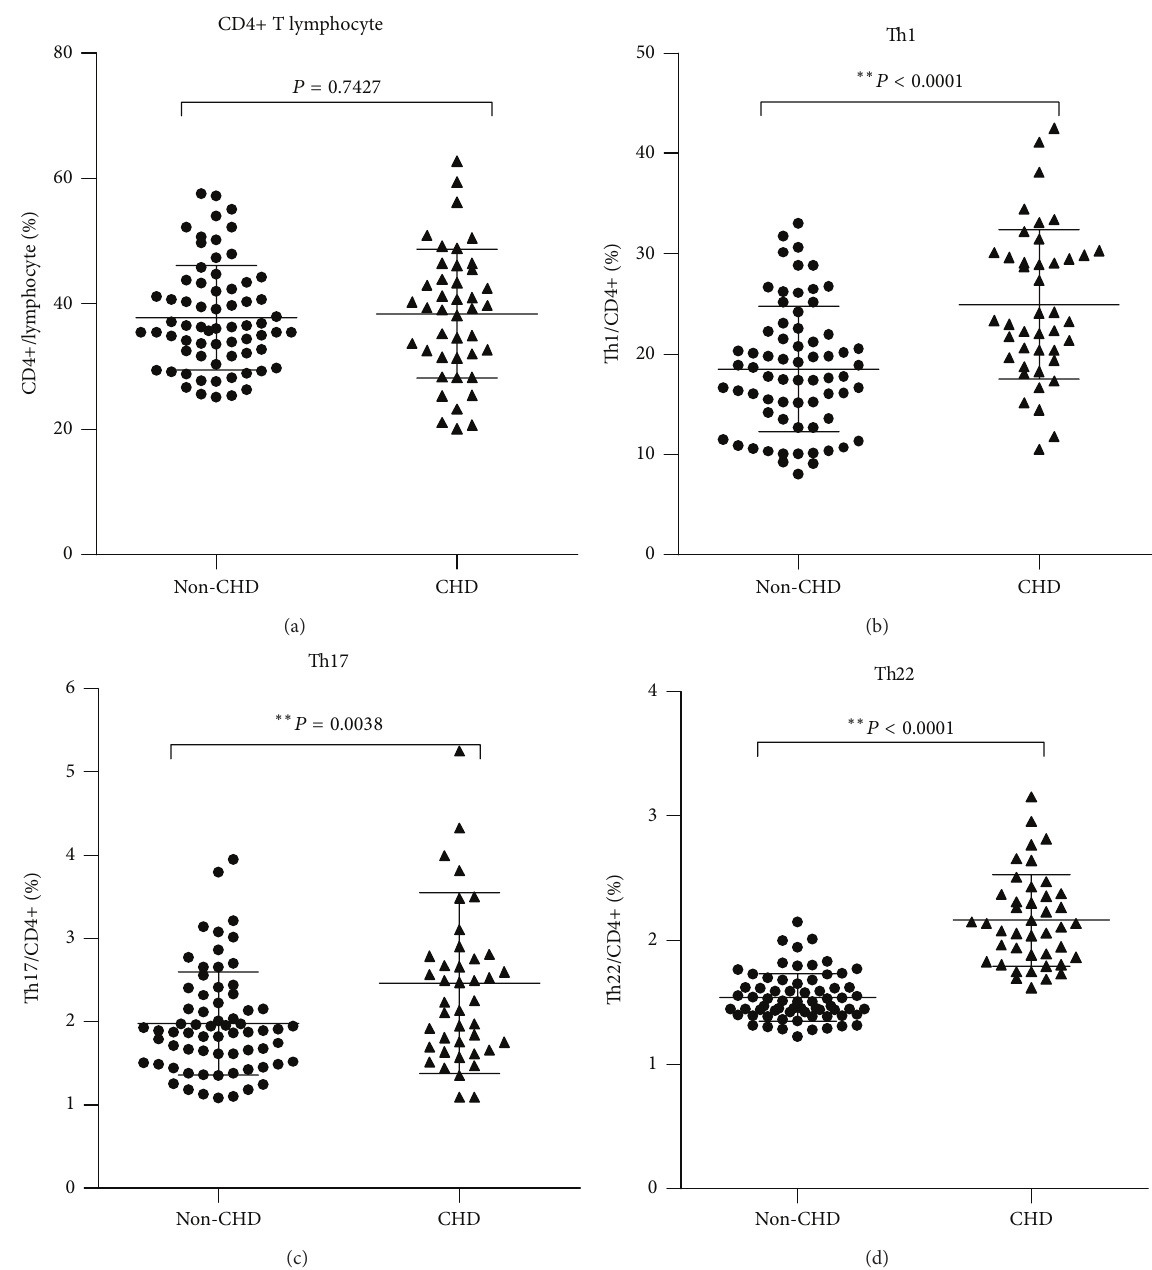
Figure 1: Peripheral frequencies of Th22, Th1, and Th17 Cells were significantly higher in diabetic patients with CHD than those without CHD. Circulating percentages of CD4+ T cells in total lymphocytes as well as Th1, Th17, and Th22 cells in total CD4+ T cells from diabetic patients with (CHD group) or without coronary heart disease (non-CHD group). (a) There was no significant difference in percentages of CD4+ T cells between non-CHD and CHD group ( 𝑃 = 0.7427 ). (b) Significant increases in Th1 were observed in CHD group ( 24.9 ± 57.46 %) compared to non-CHD group ( 18.53 ± 6.22 %) ( ∗ 𝑃 < 0.0001 ). (c) Significantly elevated percentages of Th17 cells were also found in CHD group ( 2.46 ± 1.08 % versus 1.98 ± 0.62 %) ( ∗ 𝑃 = 0.0038 ). (d) Elevations in Th22 cells in CHD were most remarkable ( 2.16 ± 0.37 % versus 1.54 ± 0.19 %) ( ∗ 𝑃 < 0.0001 ). Bars represent